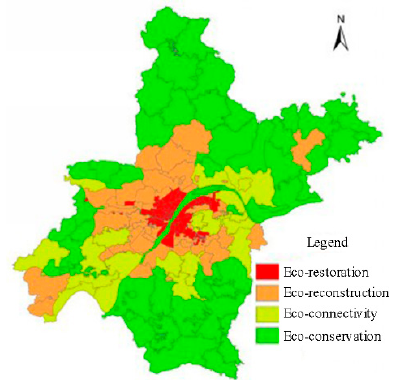
Figure 8. Distribution of ecological construction zones in Wuhan.